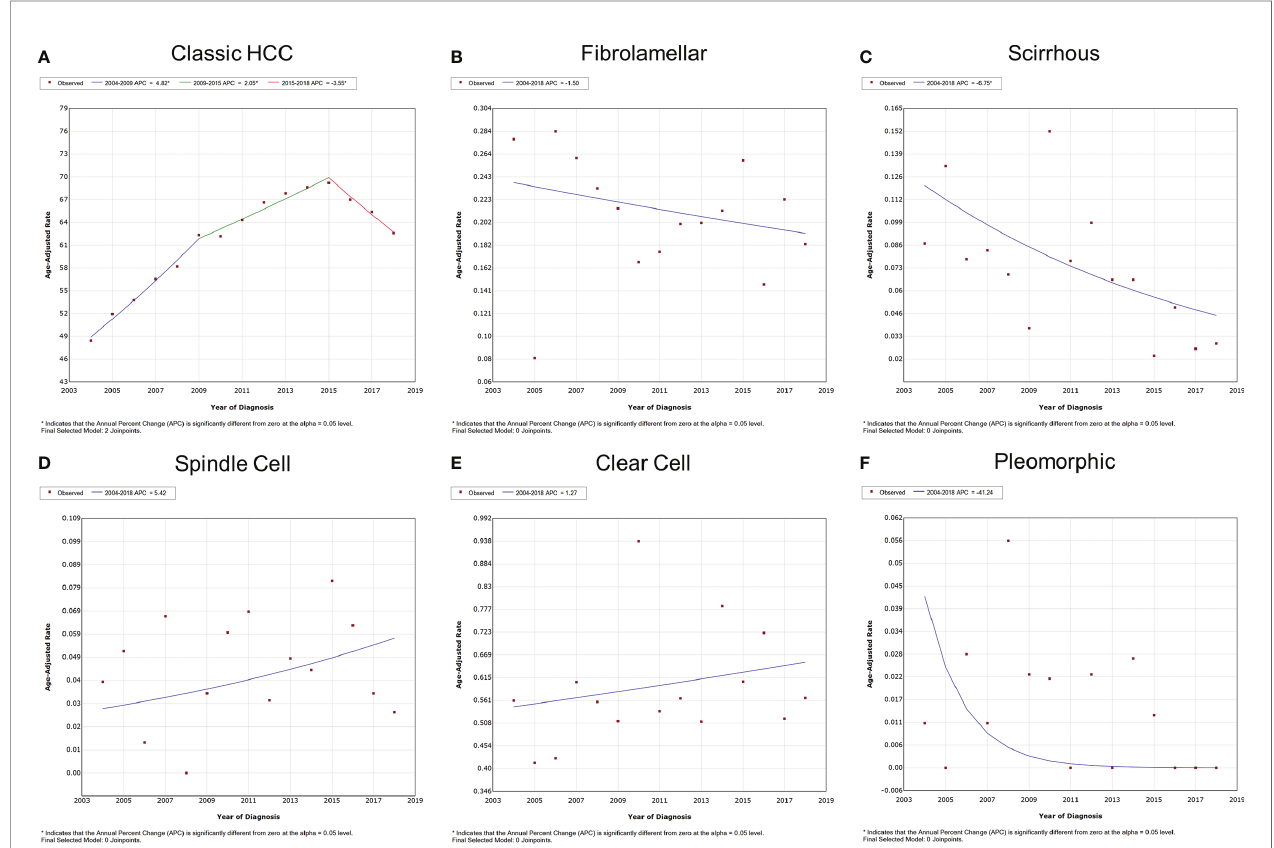
FIGURE 2 | Variation trends for the overall morbidity of different pathological subtypes of HCC from 2004 to 2018. (A) Classic HCC, (B) fi brolamellar carcinoma, (C) scirrhous carcinoma, (D) spindle cell carcinoma, (E) clear cell carcinoma, and (F) pleomorphic carcinoma. HCC, hepatocellular